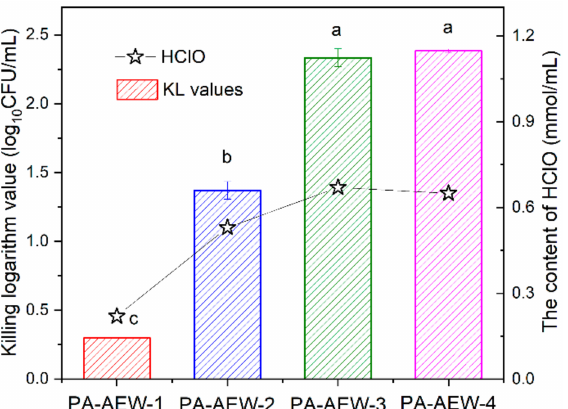
Figure 7. The relationship between the HClO content and sterilization efficiency of PA-AEW on the bacterial suspension of B. subtilis . Values with different lowercase letters above graph bars represent a significant difference ( p < 0.05).